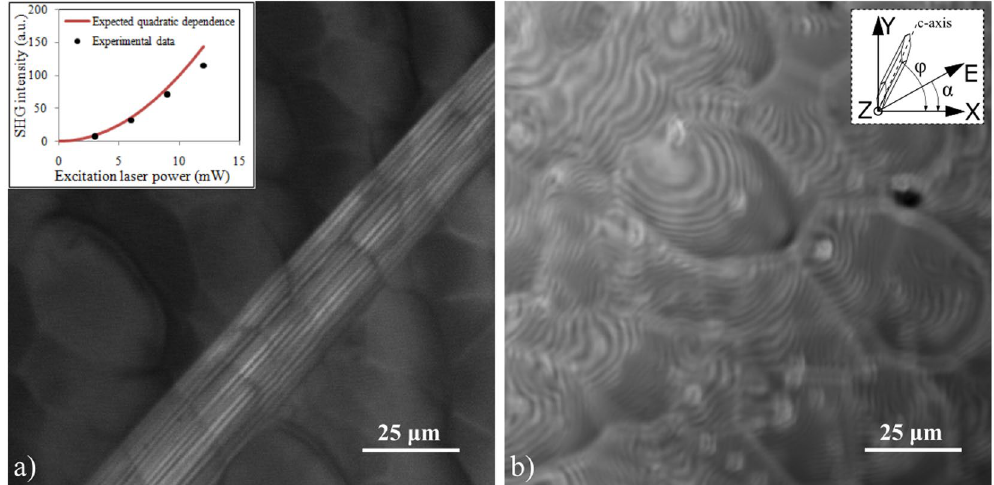
Figure 1. Images of the 4H-SiC sample proving that the SFs are only visible in the nonlinear optical image. ( a ) The polarization-independent SHG image obtained by using a circular polarized laser beam (excitation laser power 10 mW). The inset shows the SHG intensity dependence on the excitation laser beam power. The solid line represents the expected quadratic dependence for the SHG process. ( b ) A confocal microscopy reflectance image of the same area as in Fig. 1(a) which contains no information on the SFs in the 4H-SiC sample. The inset reveals the significance of α (laser beam polarization angle) and ϕ (crystal structure orientation angle) when considering the coordinates of the image plane (x,